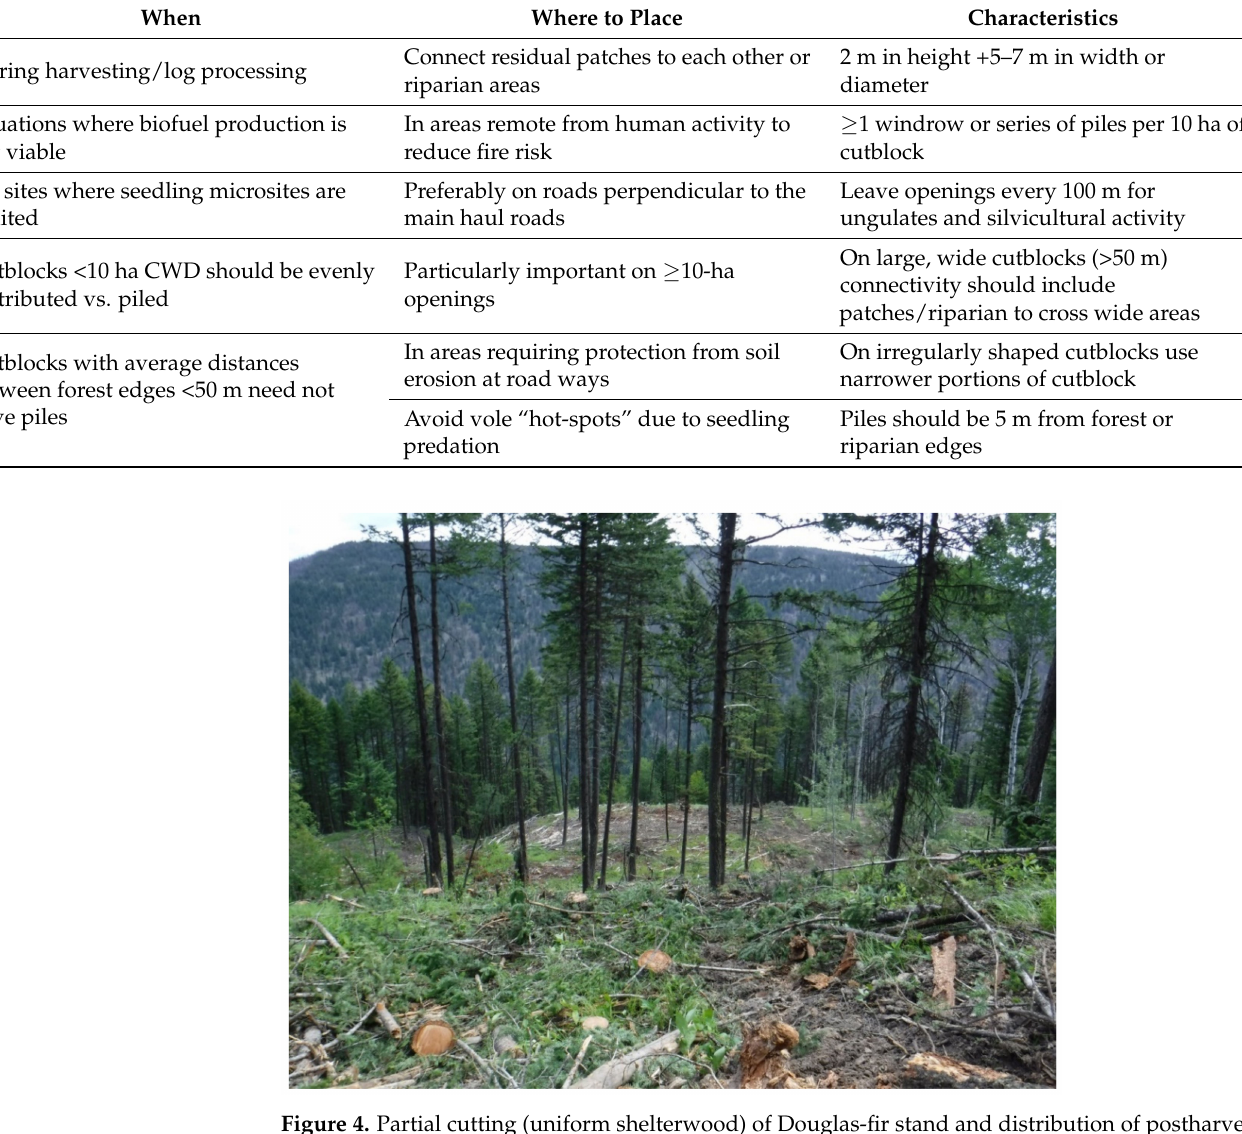
Figure 4. Partial cutting (uniform shelterwood) of Douglas-fir stand and distribution of postharvest woody debris within